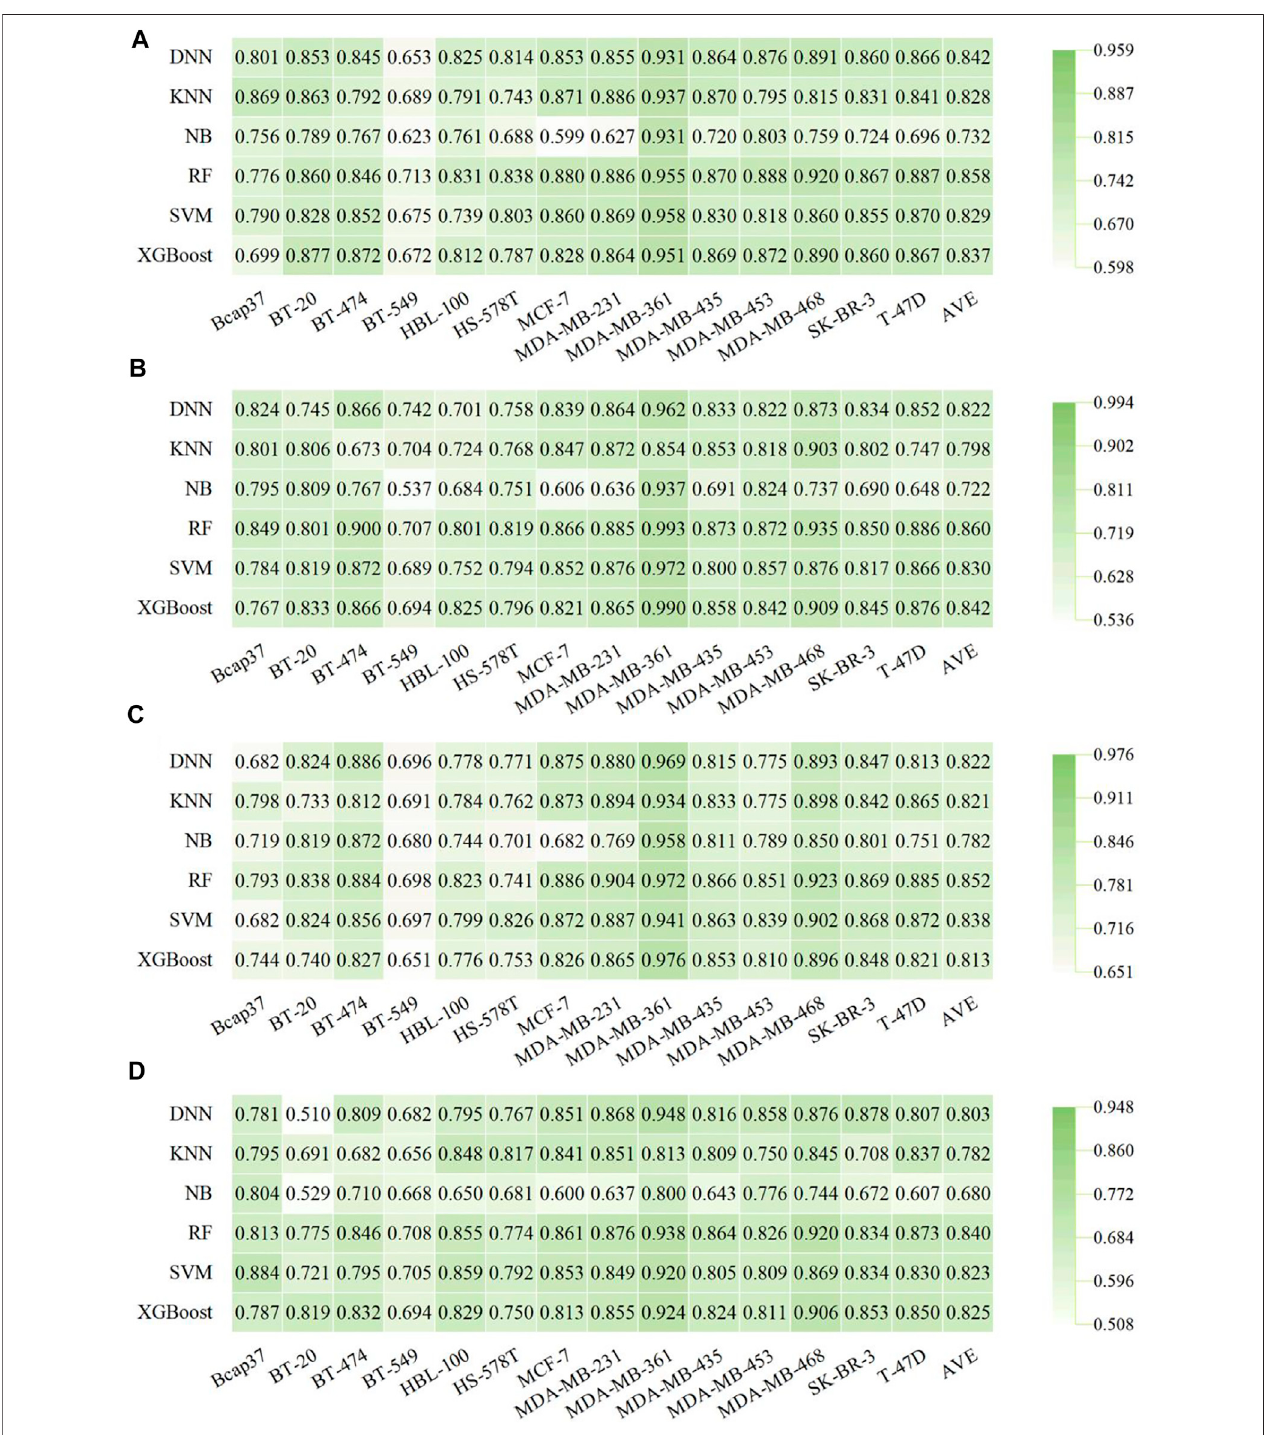
FIGURE 4 | Performance of fi ngerprint-based BC prediction models. (A) AUC results of the AtomPairs-based models. (B) AUC results of the MACCS-based models. (C) AUC results of the Morgan-based models. (D) AUC results of the PharmacoPFP-based models.